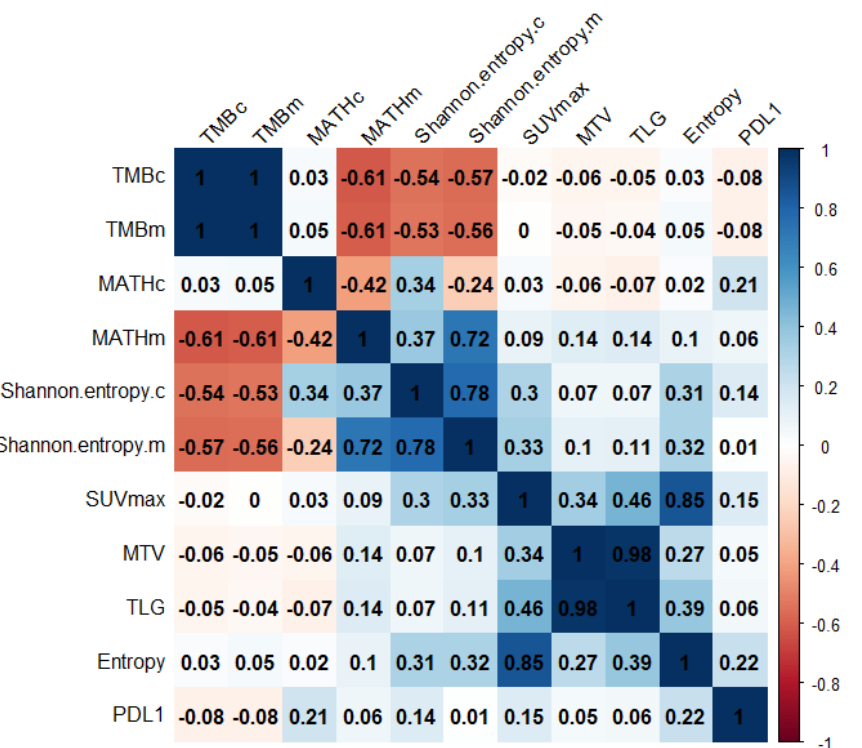
Figure 2. The correlation matrix of radiogenomic features. Values are Pearson’s correlation coeffi- cients. TMB, tumor mutation burden; MATH, mutant-allele tumor heterogeneity; SUV, standardized uptake value; MTV, metabolic tumor volume; TLG, total lesion glycolysis; PDL1, programmed cell death ligand 1 expression